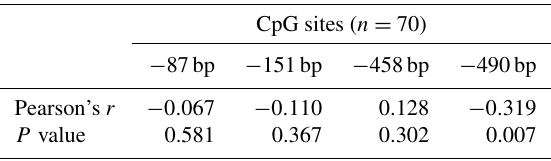
Table 4. Correlations between each DNA methylation site and PLIN1